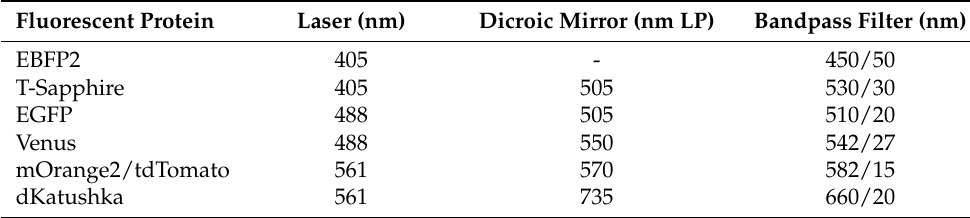
Table 1. Configuration of the BD FACS Aria Fusion 1.